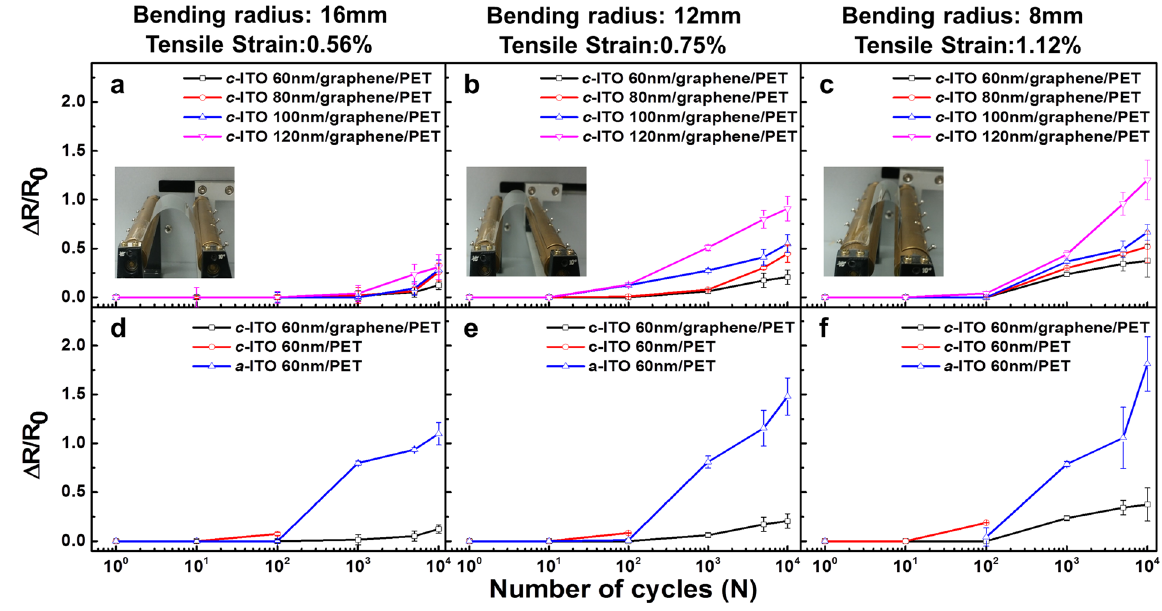
Figure 5. Normalized change in resistance, Δ R / R 0 , as a function of the number of bending cycles for the c-ITO/graphene/PET films with various ITO thicknesses at bending curvature radii/tensile strains of ( a ) 16 mm/0.56%, ( b ) 12 mm/0.75%, and ( c ) 8 mm/1.12%. Δ R / R 0 as a function of the number of bending cycles for c-ITO/graphene/PET, c-ITO/PET, and a-ITO/PET with the same ITO thickness of 60 nm at bending curvature radii/tensile strains of ( d ) 16 mm/0.56%, ( e ) 12 mm/0.75%, and ( f ) 8 mm/1.12%.